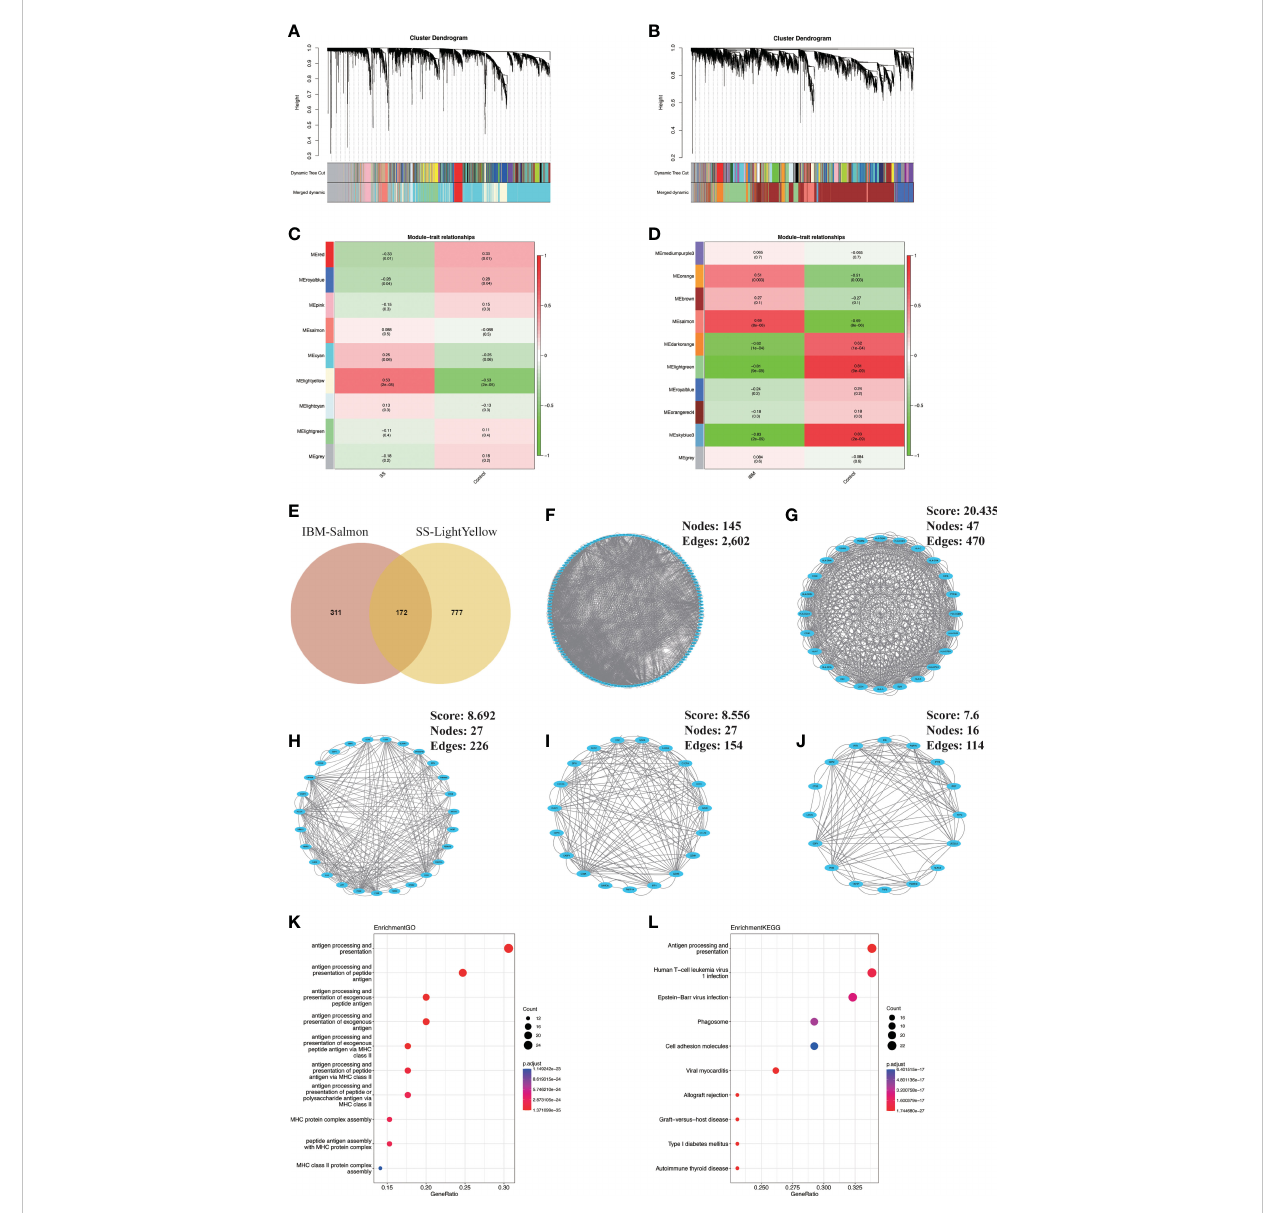
FIGURE 2 Identi fi cation and analysis of shared gene signatures in SS and IBM via WGCNA. (A – D) WGCNA of the GSE173808 and GSE151757 datasets. (A) The coexpression gene cluster dendrogram in SS. (B) The coexpression gene cluster dendrogram in IBM. (C) Correlation analysis between module genes and clinical phenotypes in SS. (D) Correlation analysis between module genes and clinical phenotypes in IBM. (E) Venn diagram for intersecting genes between the light-yellow module of SS and the salmon module of IBM. (F) The PPI network of the intersecting genes. (G – J) Four clusters extracted by MCODE. (K) The top 10 GO terms of four gene clusters. (L) The top 10 KEGG pathways of four gene clusters. WGCNA, weighted gene coexpression network analysis; SS, Sjögren syndrome; IBM, inclusion body myositis. PPI, protein − protein interaction; MCODE, Minimal Common Oncology Data Elements; GO, Gene Ontology; KEGG, Kyoto Encyclopedia of Genes and